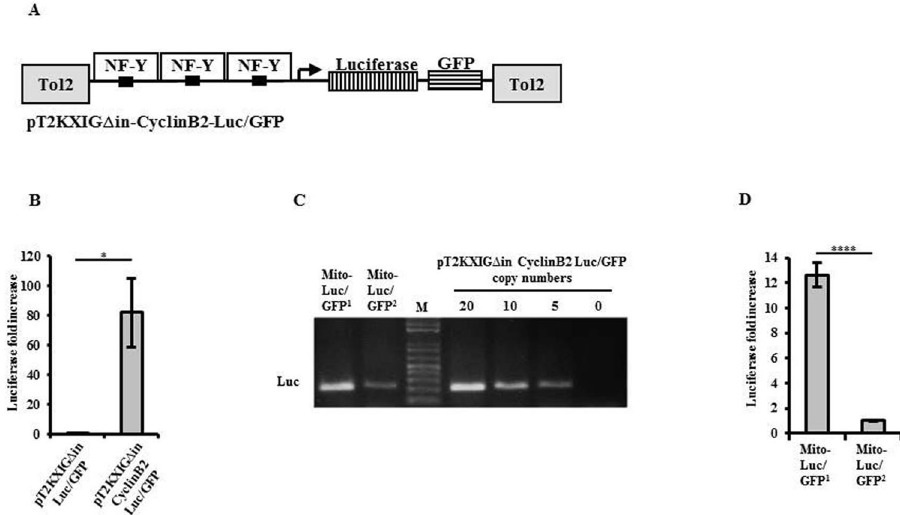
Figure 1. Establishing Tg (cyclin B2:Luc/GFP) MITO-Luc/GFP transgenic zebrafish lines. ( A ) Schematic representation of the pT2KXIGΔin-cyclin B2-Luc/GFP expression vector. A fragment of murine cyclin B2 promoter containing CCAAT boxes (black) was cloned upstream of the firefly luciferase gene (vertical stripes) and the green fluorescent protein GFP (horizontal stripes), in the pT2KXIGΔin plasmid containing the Tol 2 transposable element (gray). The binding of NF-Y to the CCAT boxes is shown. ( B ) Relative luciferase activity obtained in one to four-cell stage AB embryos transiently injected with the pT2KXIGΔin-Luc/GFP or the pT2KXIGΔin-cyclin B2-Luc/GFP. The error bars are mean standard deviations from two experiments performed in duplicate. Asterisks denote significant differences between pT2KXIGΔin-cyclin B2-Luc/GFP